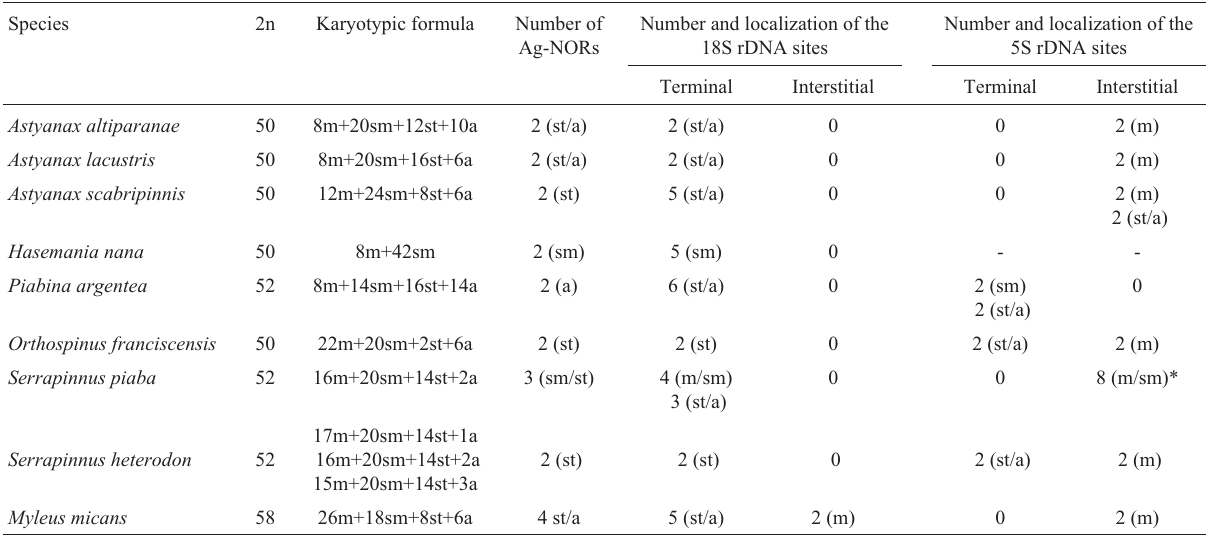
Table1 -Diploidnumber,karyotypicformulaandnumberof18Sand5SrDNAsitesinnineCharacidaespecies;2n:diploidnumber;m:metacentric;sm: submetacentric; st: subtelocentric; a: acrocentric chromosomes. Species